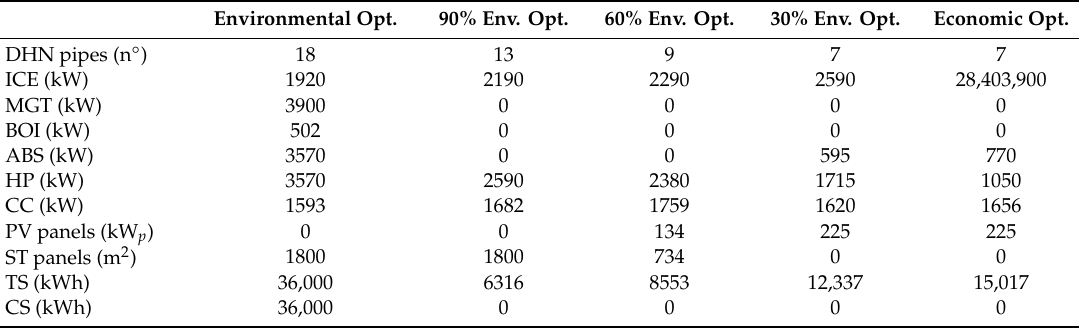
Table 9. Optimal configurations of the distributed generation